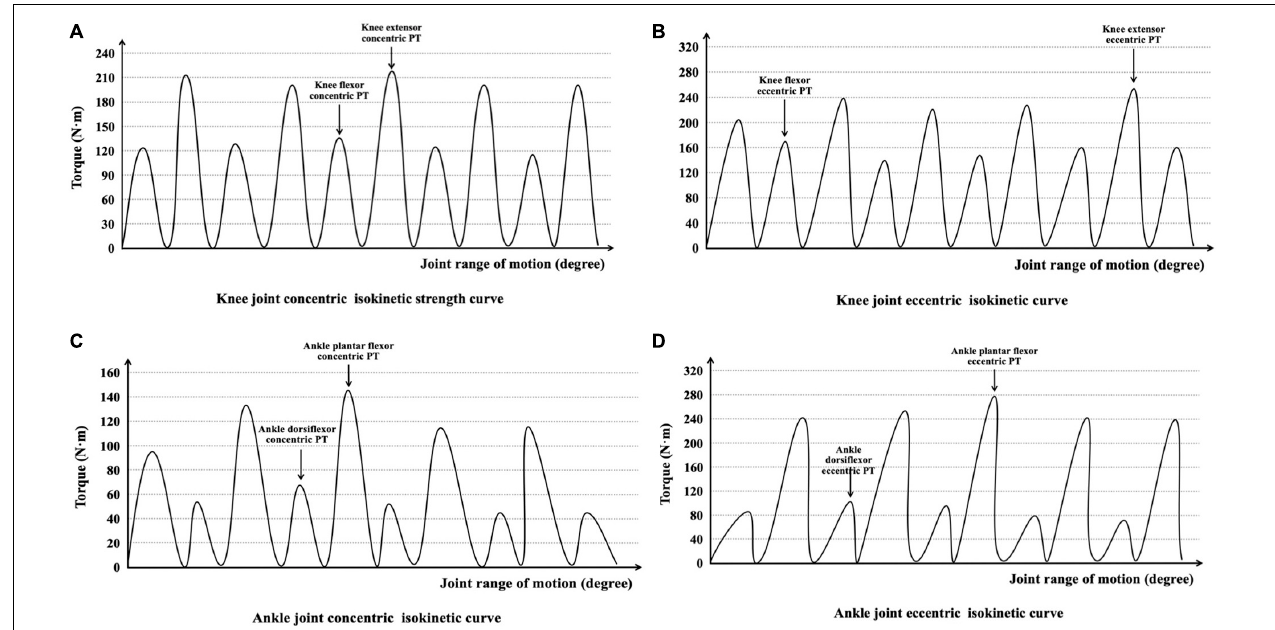
FIGURE 2 | Interpretation of (A) knee joint concentric isokinetic strength curve, (B) knee joint eccentric isokinetic curve, (C) ankle joint concentric isokinetic curve, and (D) ankle joint eccentric isokinetic curve during the isokinetic strength